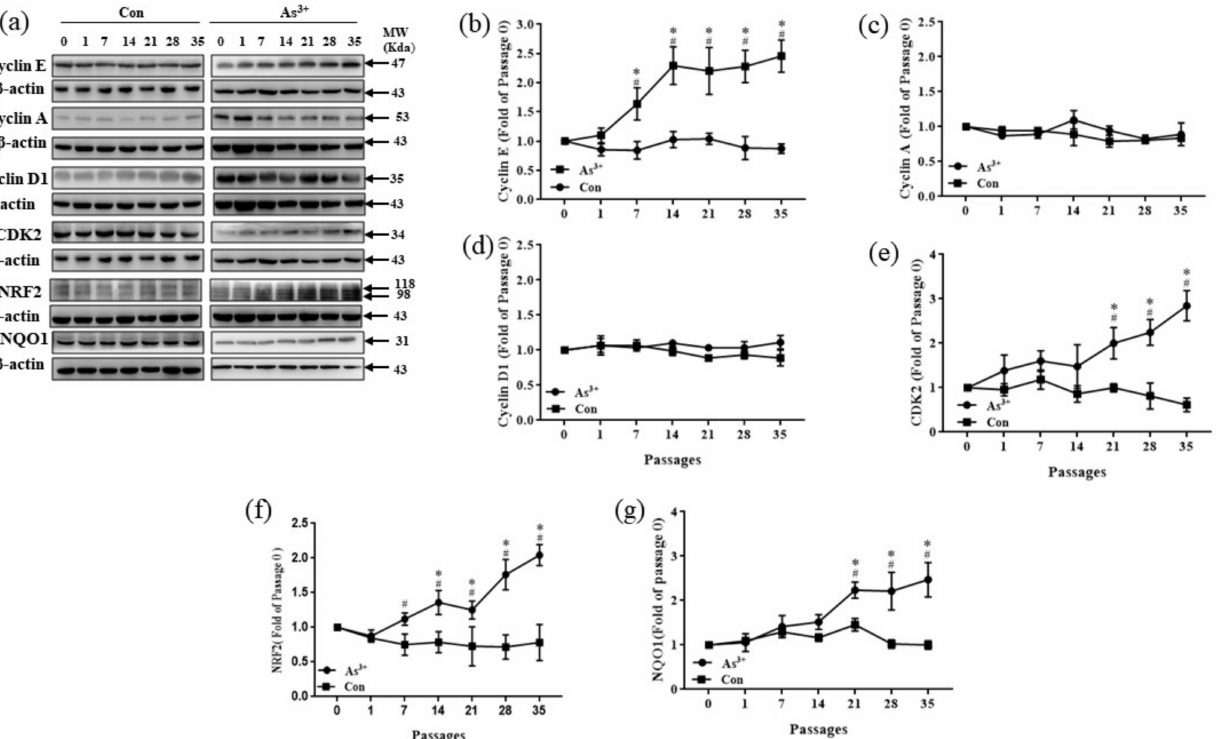
Figure 2. Relative protein expression and quantification of changes in NRF2, NQO1, and cell cycle- related proteins in HaCaT cells exposed to 1.0 µ M arsenite or without arsenite exposure for different passages. ( a ) Protein bands. ( b ) Relative protein levels of Cyclin E. ( c ) Relative protein levels of Cyclin A. ( d ) Relative protein levels of Cyclin D1. ( e ) Relative protein levels of CDK2. ( f ) Relative protein levels of NRF2. ( g ) Relative protein levels of NQO1. Error bars are the mean ± SD ( n = 3). * Compared with the passage-matched control group, p < 0.05; # Compared with the experimental control group, p <